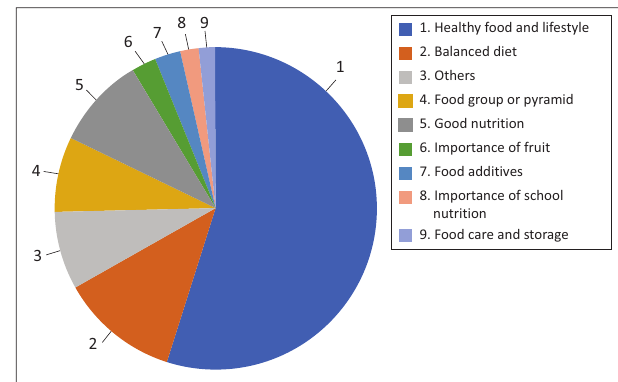
FIGURE 6: Nutrition topics that the educators felt comfortable in teaching the learners .